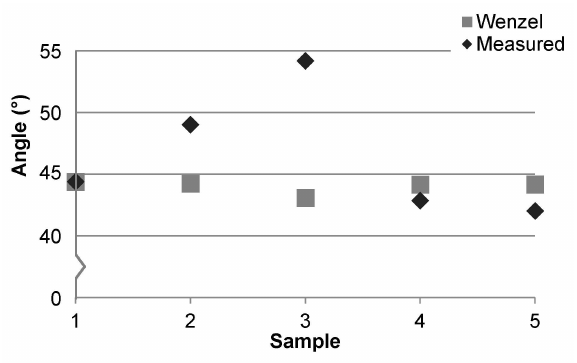
Figure 4. Measured and predicted contact angles of DI water based on S dr